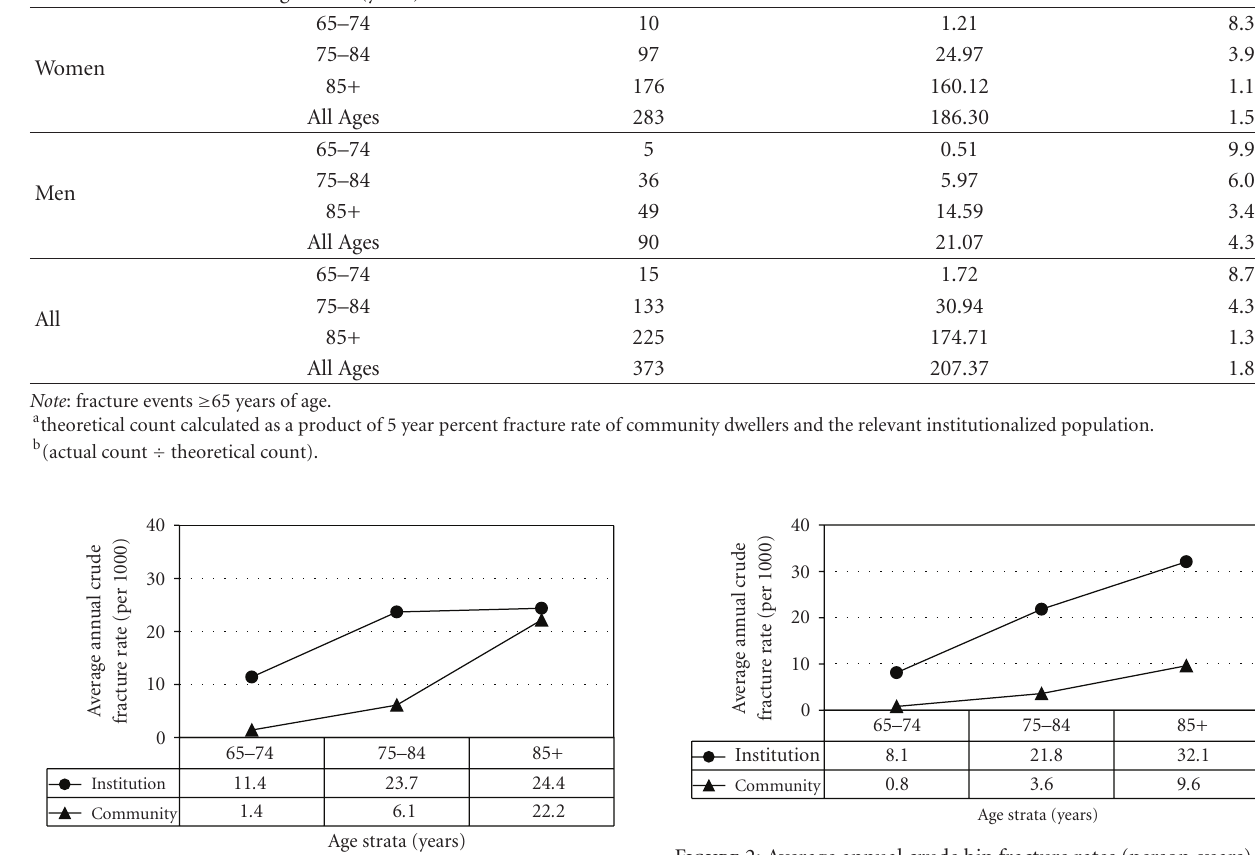
Figure 1: Average annual crude hip fracture rates (person-years) in women by age strata and pre-fracture residence (2002–2006).